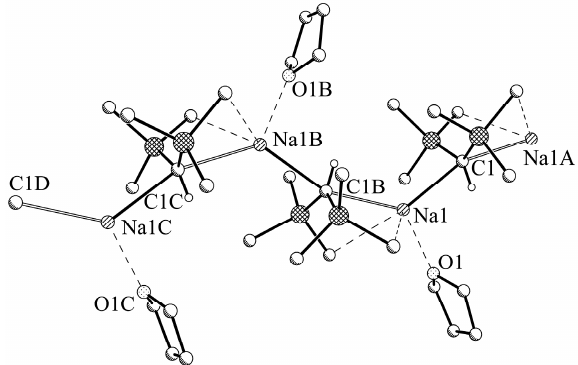
Figure 5. Trimeric section of polymeric [NaCH(SiMe 3 ) 2 -THF] ∞ , 2a . Selected hydrogen atoms are omitted for clarity. Symmetry operator A: − x +0.5, y − 0.5, − z +0.5; B: − x +0.5, y +0.5, − z +0.5.